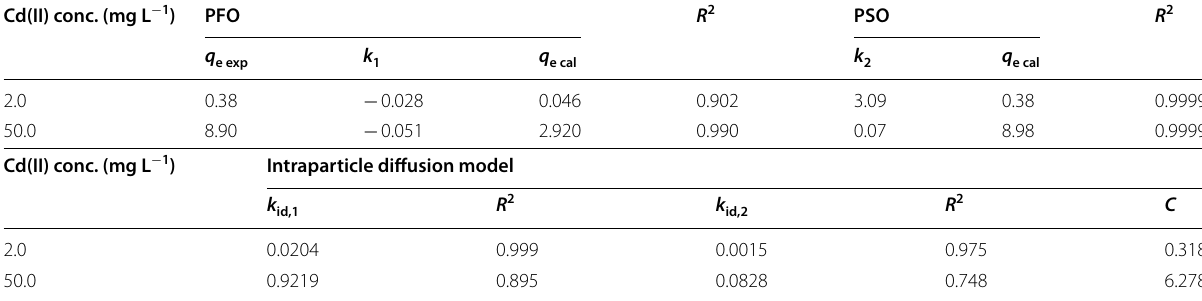
Table 3 Kinetics parameters for Cd(II) ions adsorption onto BTW Cd(II) conc. (mg L − 1 )